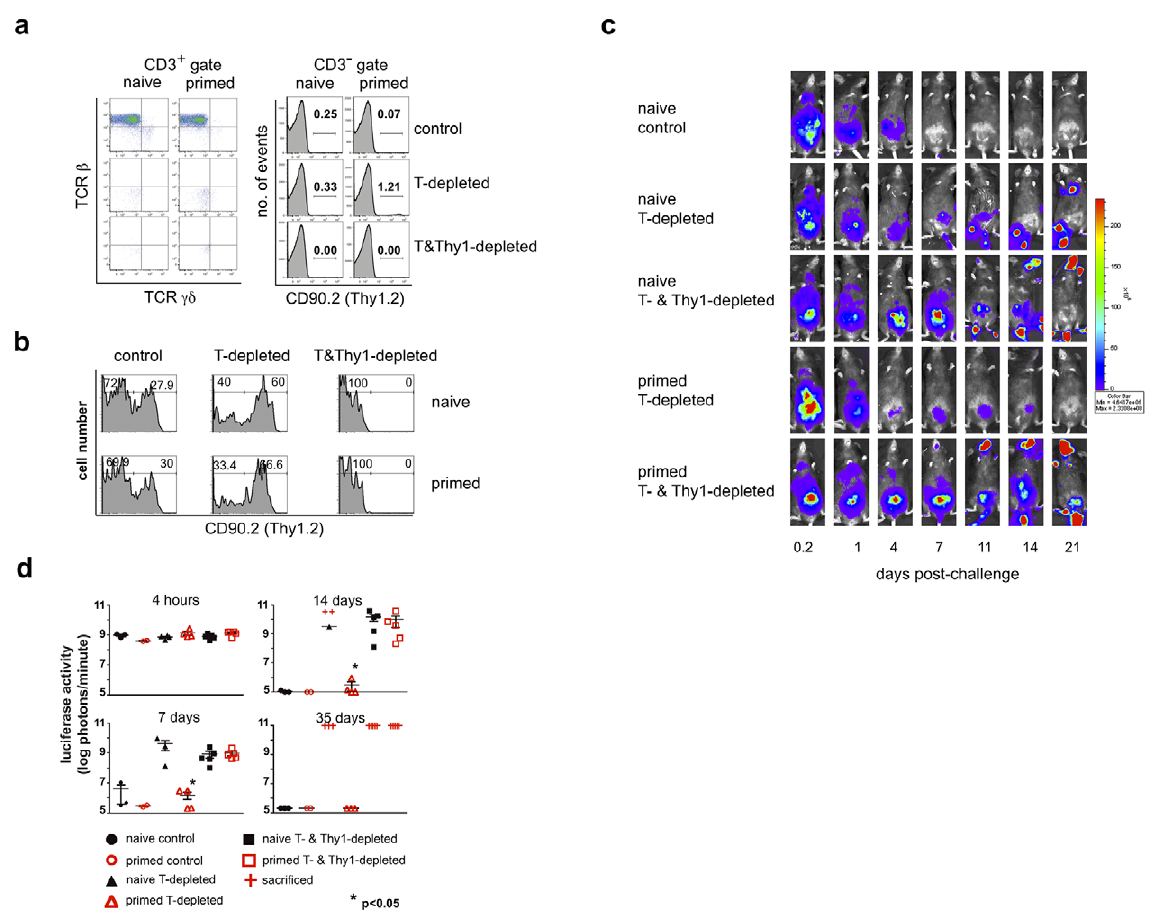
Figure 2. A Thy1 + cell population mediates innate protection against a secondary challenge with vaccinia virus. Eight months after the initial administration of vaccinia virus (primed) or PBS (naı¨ve), IgH ko mice were treated with either isotype control or depleting monoclonal antibodies, then challenged ten days later with 2 6 10 6 pfu rVV-luc. Isotype control and depleting monoclonal antibodies were administered ip every 2 weeks beginning one week to ten days prior to viral challenge. ( a ) Representative flow cytometric plots of staining of all cells that fall within the CD3 + and CD3 2 lymphocyte gates from peripheral blood 2 weeks after the secondary challenge are shown. (b) Histograms of CD90.2 expression by the NK cell population (gated on CD3 2 NK1.1 + cells) isolated from peripheral blood of each of the indicated groups are shown. ( c ) IVIS images of representative IgH ko mice from naı¨ve isotype control, naı¨ve and primed T cell-depleted, and naı¨ve and primed T- and Thy1(CD90.2) + - cell depleted groups are shown at various time points following secondary challenge with rVV-luc. ( d ) The measurements of rVV-luc viral loads in each group over time are shown, with relative viral loads based on the number of photons emitted normalized for a one minute exposure. The measurement for each individual mouse is plotted, and the mean is indicated by the centerline with error bars representing the SEM. Statistical significance between T-depleted and T&Thy1-depleted groups was assessed by t-tests using Mann-Whitney analysis and is indicated by the asterisk (p , 0.05). Results are representative of 4 independent